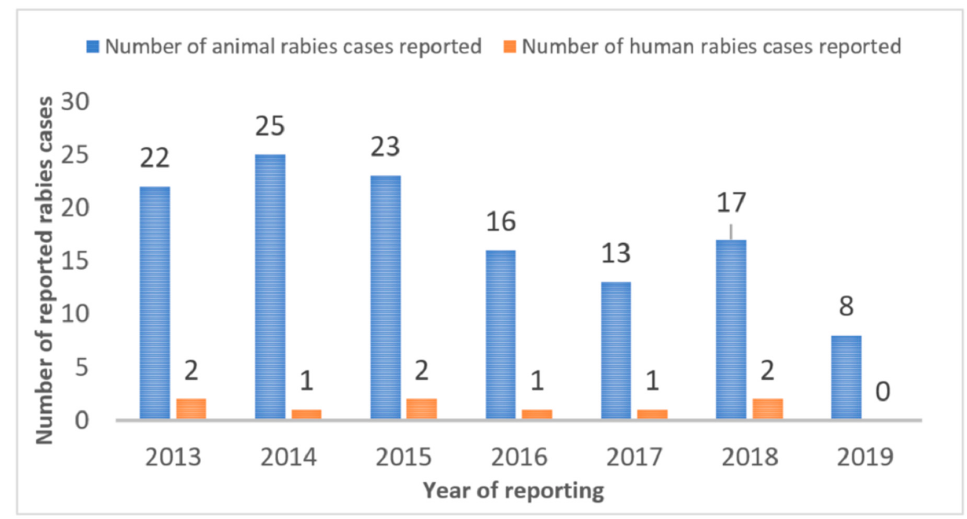
Figure 10. Reported rabies cases in animals and humans in Quezon City, pre- and post-2018 vaccination drive.